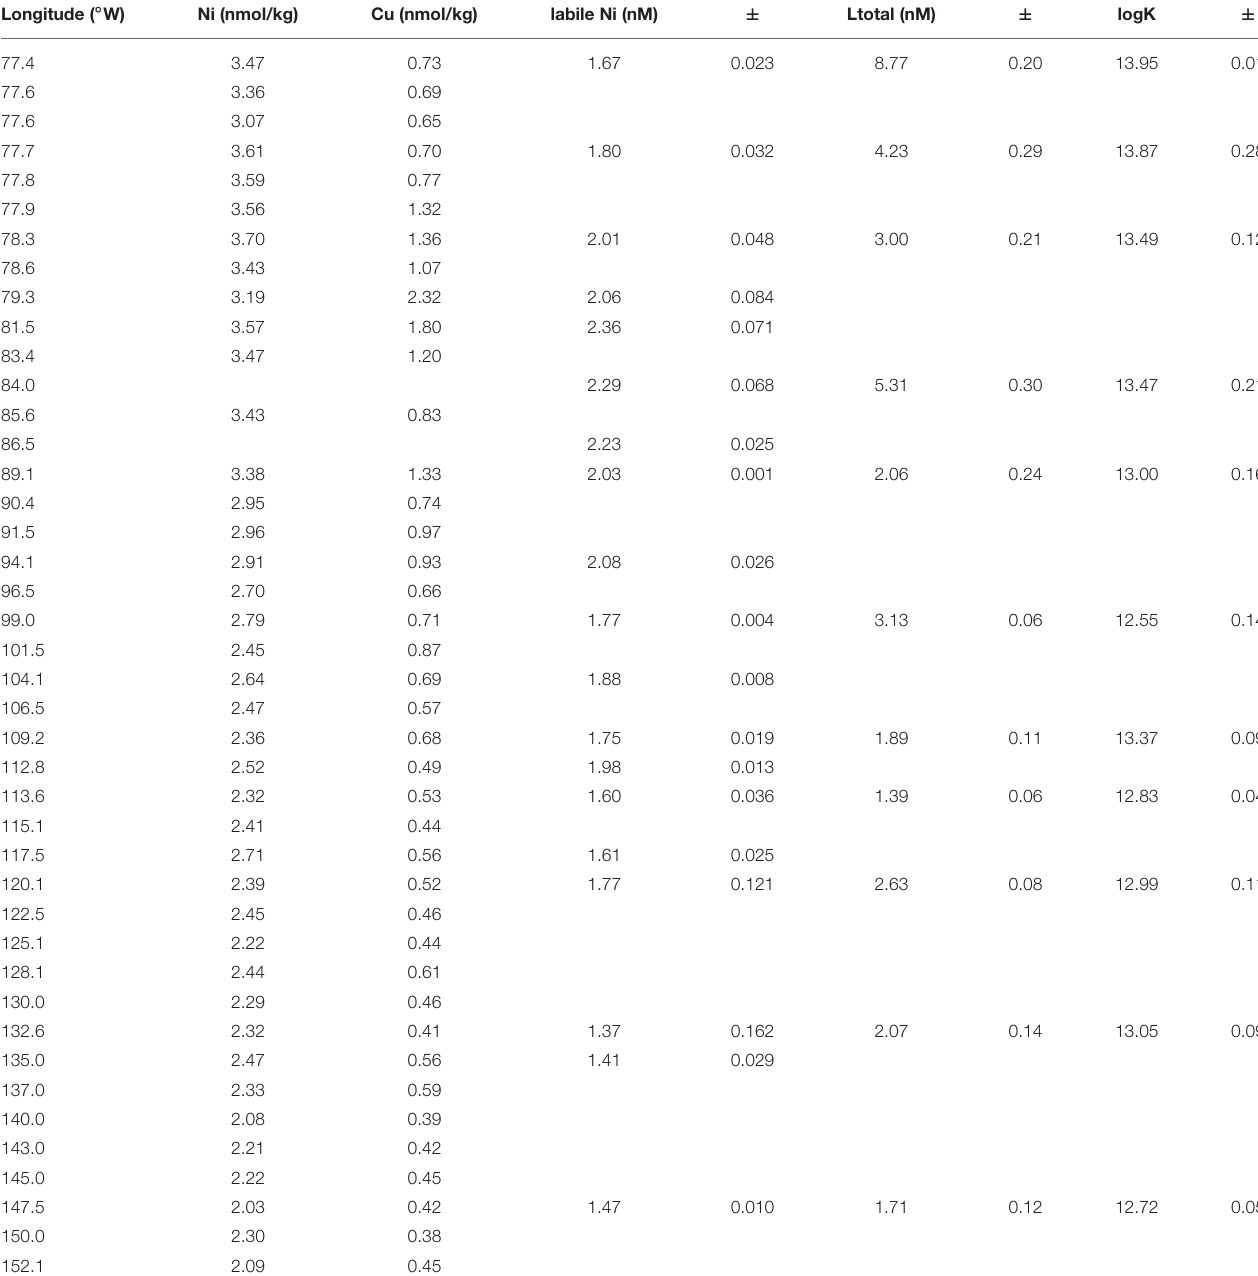
TABLE 1 | Concentration of dissolved Ni, Cu, and Cu ligands in surface waters of the Eastern Pacific. Longitude ( ◦